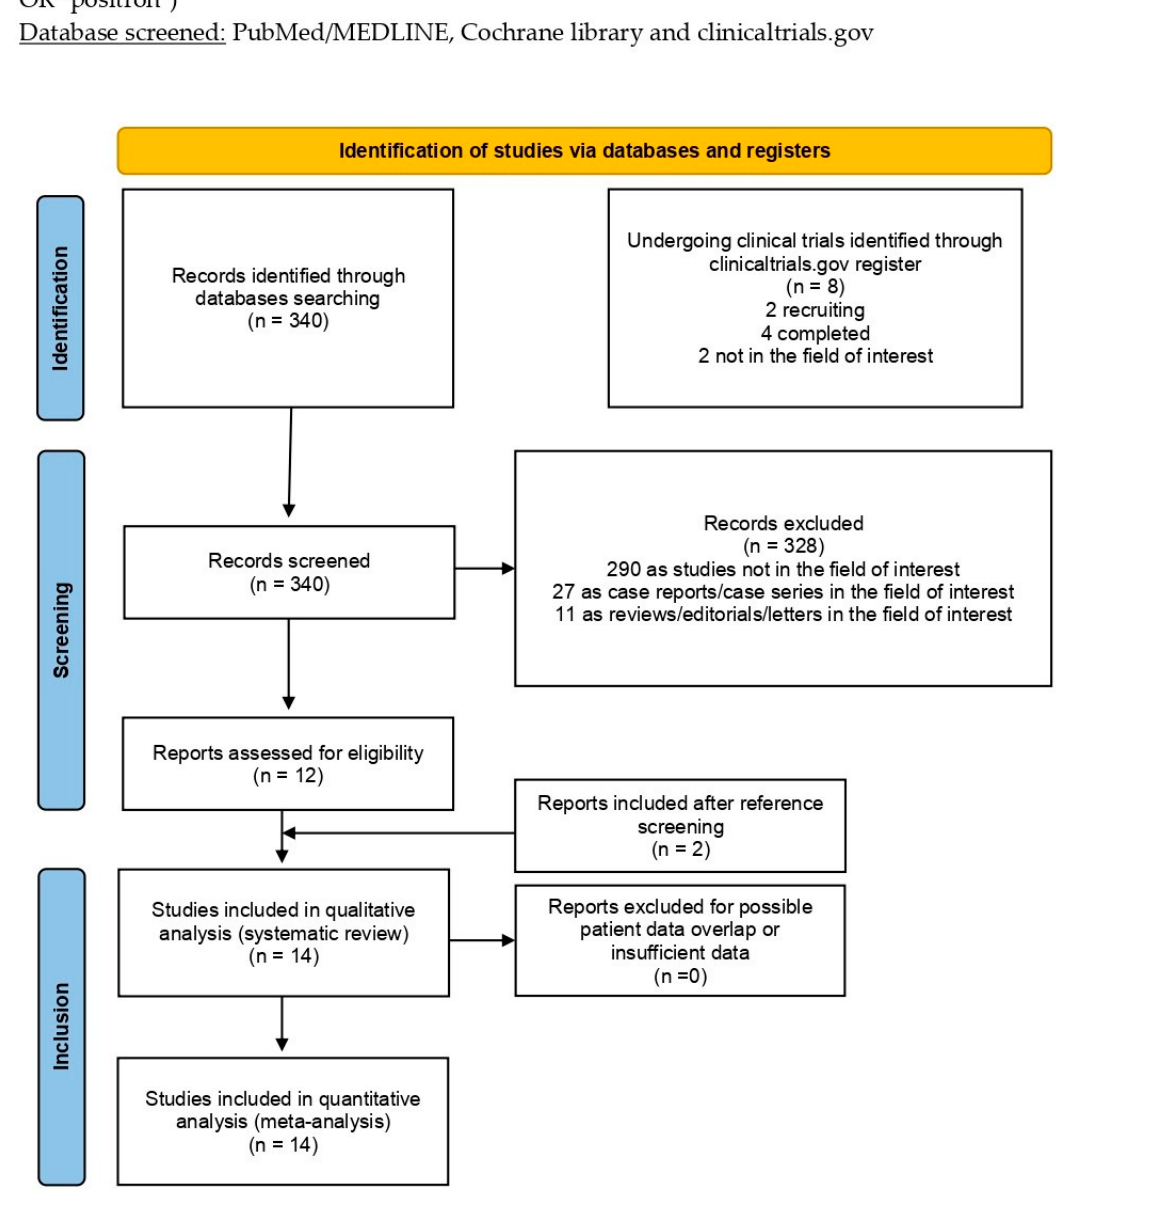
Figure 1. Comprehensive overview of the study selection process for the systematic